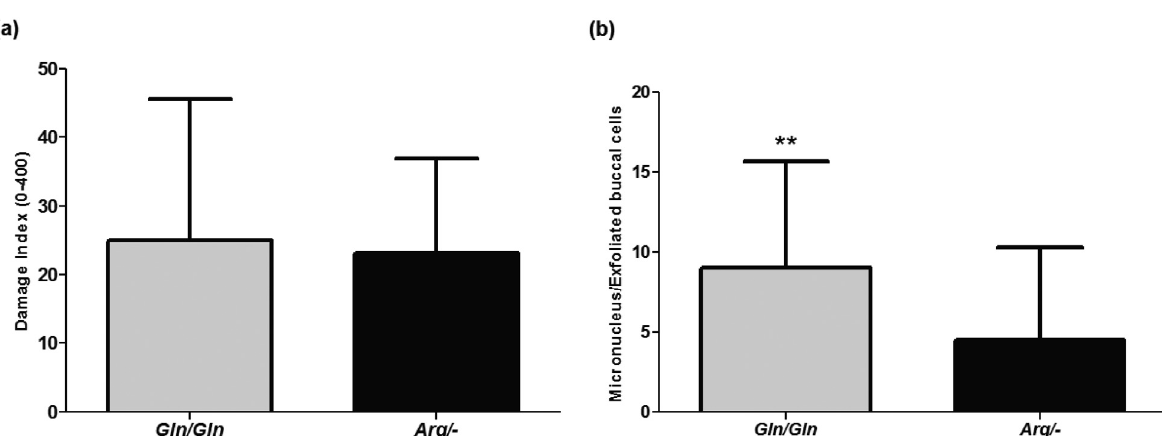
Figure 1 - Effect of individual genotype ( PON1 ) on the level of different biomarkers evaluated in exposed group (mean ± S.D.): (a) Comet assay and (b) Micronucleus test. ** Signi fi cant at P<0.01 in relation to PON1 Arg/- genotype; t- Student